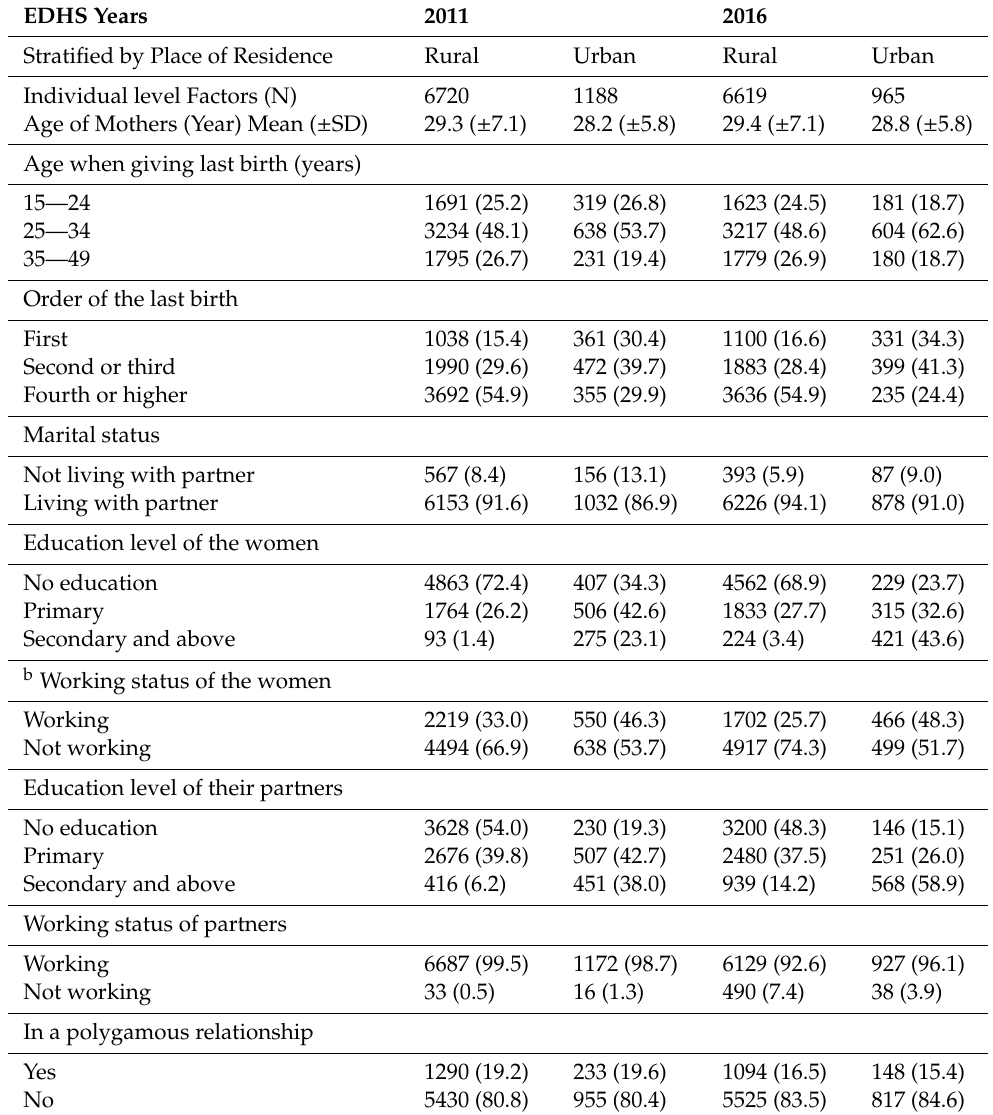
Table 1. Background characteristics of 15,492 women with a live birth in the five years preceding the 2011 or 2016 surveys (Ethiopian Demographic Health Survey